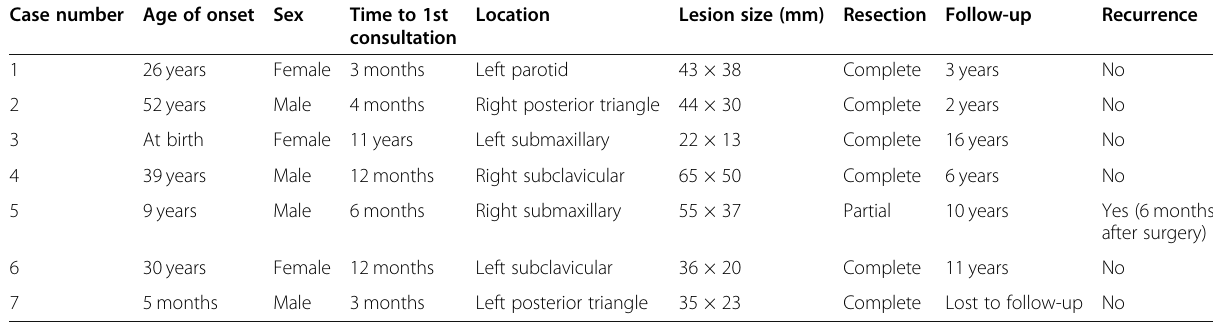
Table 2 Clinical profiles and response to treatment in our patients treated surgically Case number Age of onset Sex